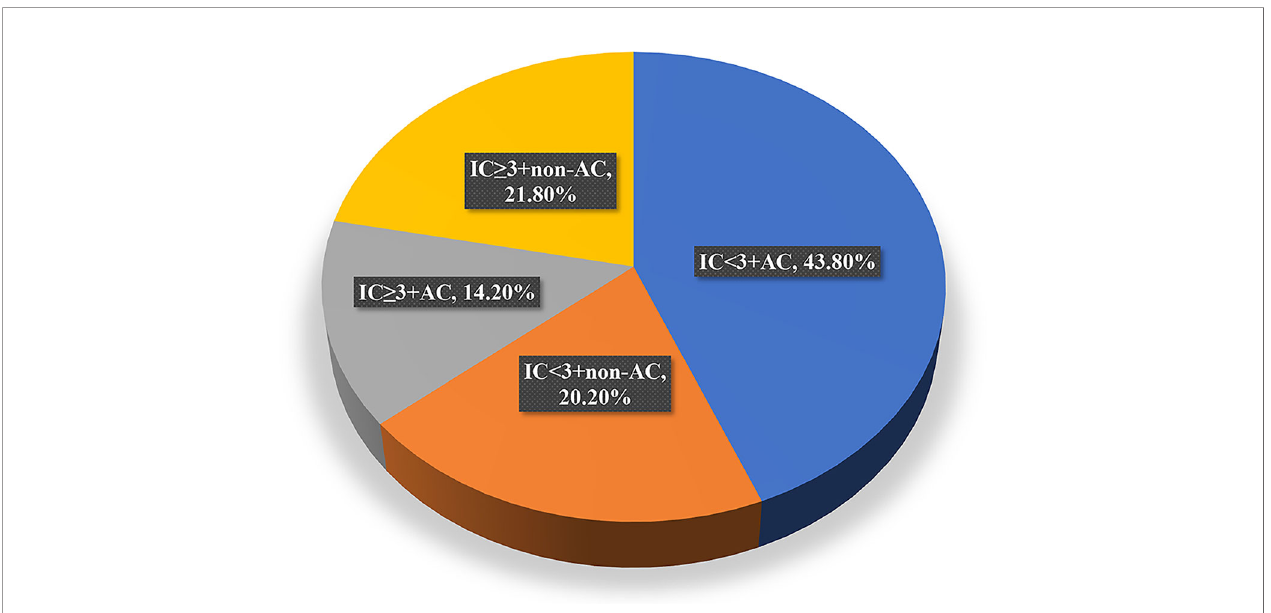
FIGURE 4 | Distribution of patients receiving each of the four treatment modalities. IC, induction chemotherapy; AC, adjuvant